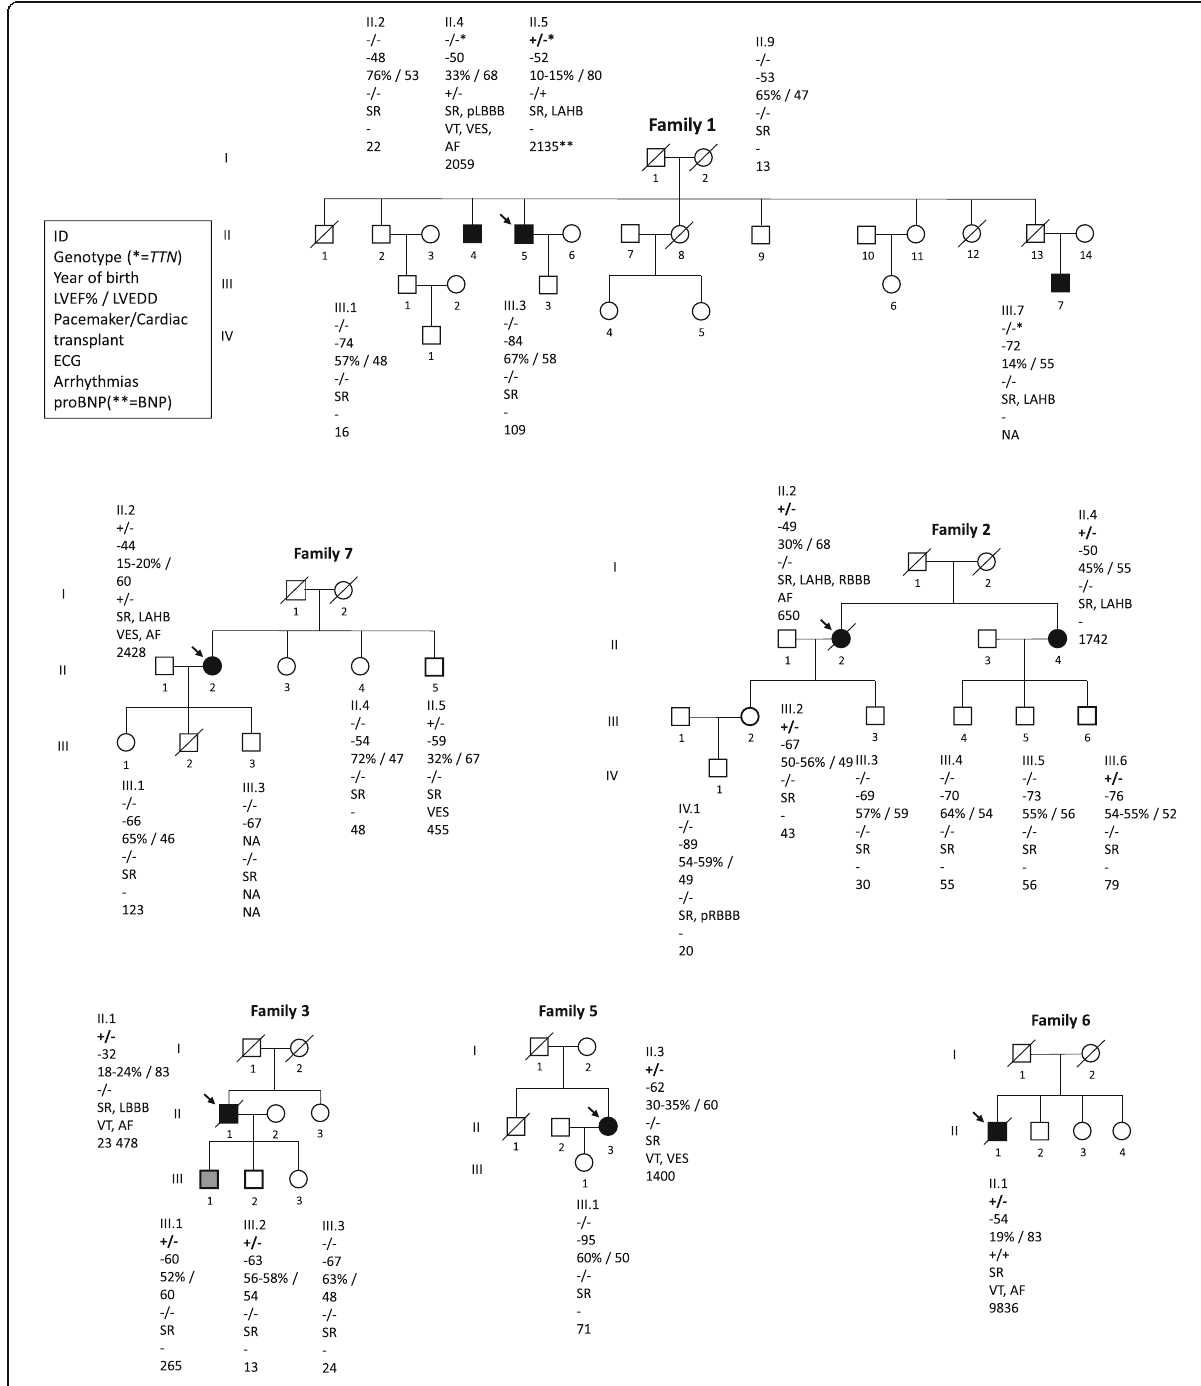
Fig. 1 Pedigrees of six families affected with the DSP c.6310delA, p.(Thr2104Glnfs*12) variant. Squares represent men and circles women. Black- filled symbols represent individuals who fulfill DCM diagnostic criteria. Grey symbol represents individual who was considered affected. Arrows indicate index patients. Carriers of the DSP p.(Thr2104Glnfs*12) variant are marked in symbols with bolded outlines. Genotypes: +/ − heterozygous for the DSP p.(Thr2104Glnfs*12), − / − wild type allele, * TTN p.(Val33411Thrfs*32). Year of birth, left ventricular ejection fraction and end-diastolic diameter and other clinical features listed below the symbols. LVEF left ventricular ejection fraction (%); LVEDD left ventricular end-diastolic diameter (mm). Pacemaker/Cardiac transplant: + indicates yes, − indicates no. ECG (electrocardiogram) - SR indicates sinus rhythm; (p)L/RBBB (partial) left/right bundle branch block; LAHB left anterior hemiblock. Arrhythmias - VT for ventricular tachycardia; VES for ventricular extrasystoles; AF for atrial fibrillation; NA not available. ProBNP pro b-type natriuretic peptide, ** BNP b-type natriuretic